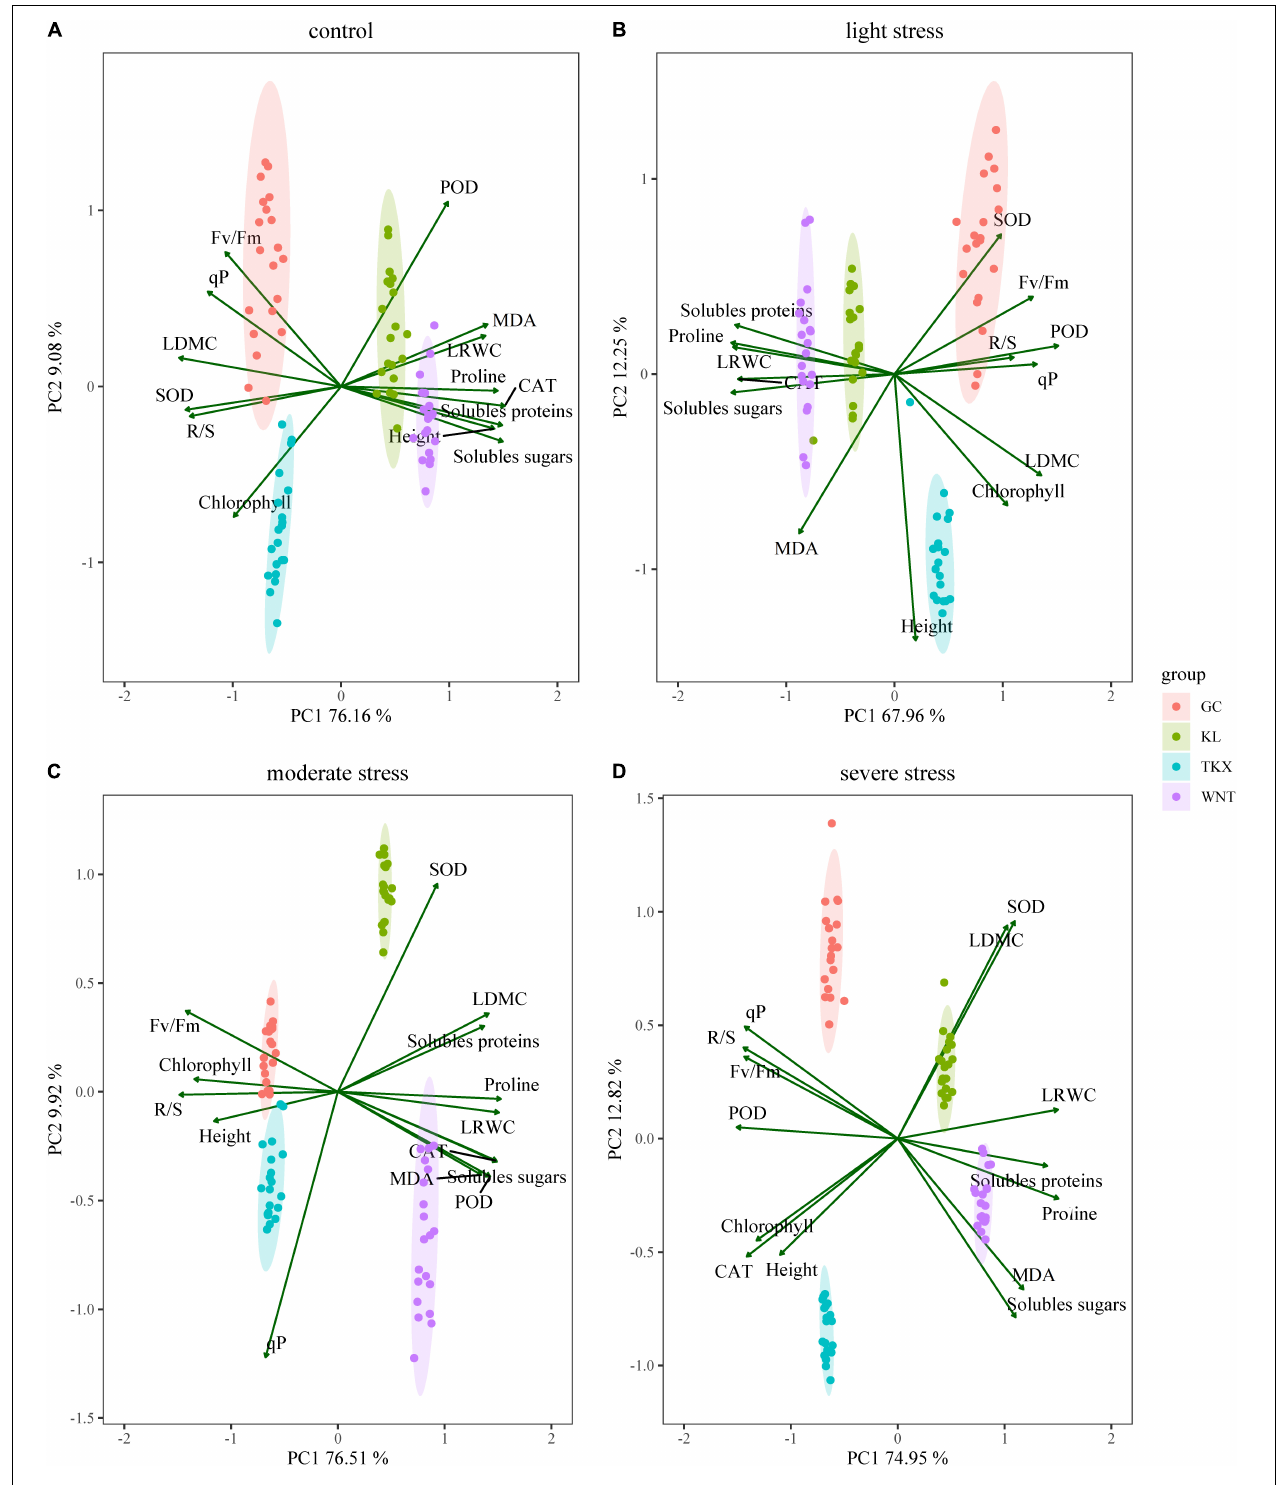
FIGURE 6 | Site score map of two principal components of S. rostratum . in different geographical populations under control condition (A) , LD stress (B) , MD stress (C) , and SD stress (D) treatments. Principal component analysis variables included plant height (Height), leaf relative water content (LRWC), leaf dry matter content (LDMC), root shoot ratio (R/S), chlorophyll content (Chlorophyll), maximum photochemical efficiency ( F v / F m ), photochemical quenching coefficient ( q P), malondialdehyde (MDA), superoxide dismutase (SOD), peroxidase (POD), catalase (CAT), proline, soluble protein, and soluble sugar specific activity.